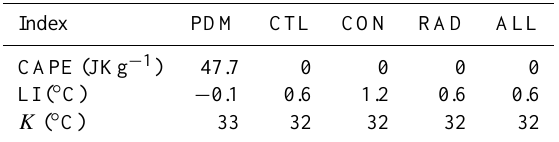
Table 2. Values of the CAPE, LI, and K indexes for PDM sound- ing and those produced by the model at the same time